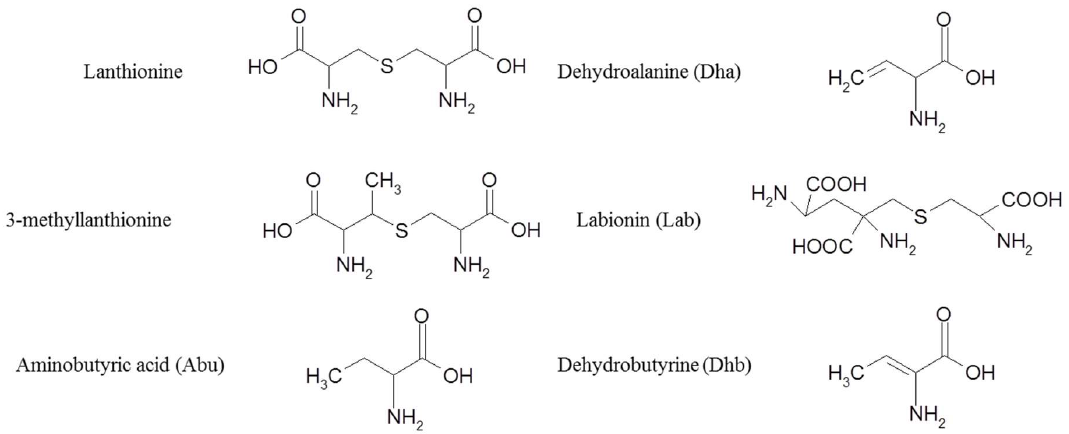
Figure 2. Structures of some unusual amino acids retrieved in bacteriocins produced by Gram-positive bacteria.